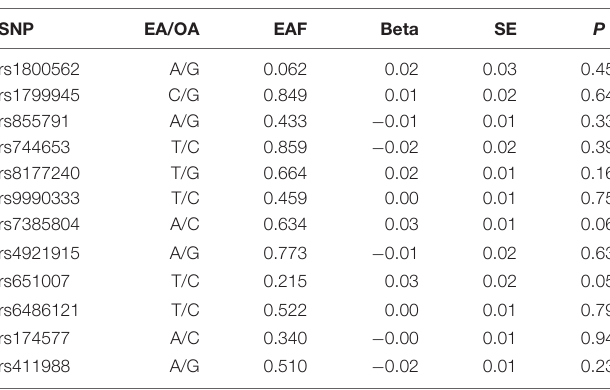
SNP, single nucleotide polymorphism; ALS, amyotrophic lateral sclerosis; AVS, ALS variant server; GWAS, genome-wide association study; EA, effect allele; OA, other allele; EAF, effect allele frequency; SE, standard